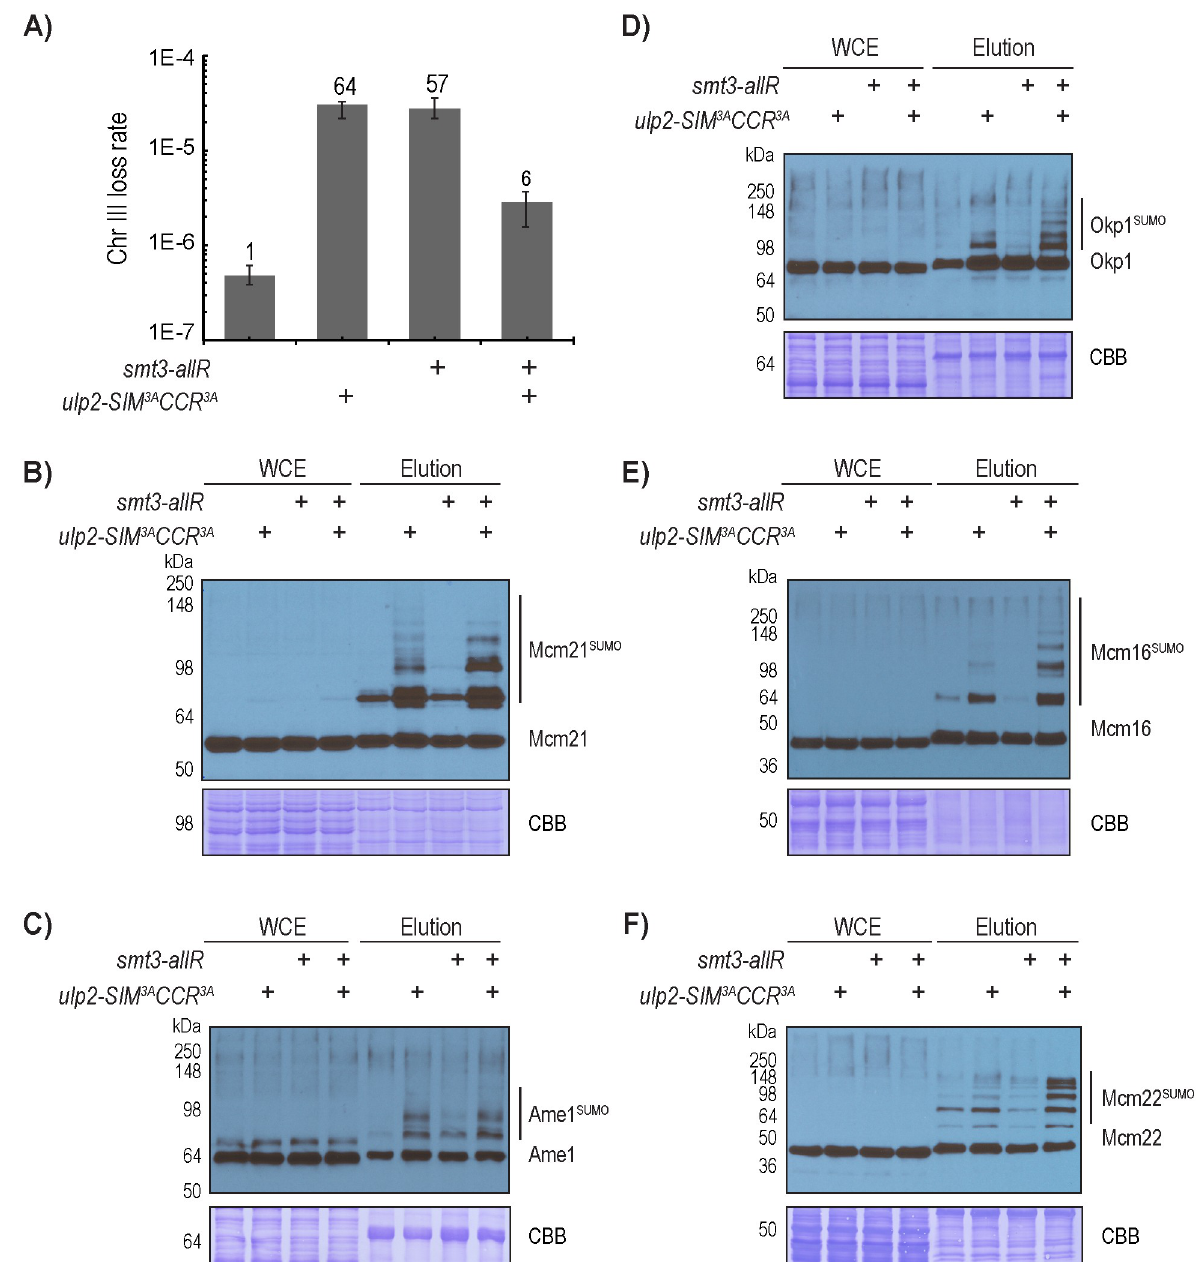
Fig 6. CCAN sumoylation and chromosome segregation are affected by changes in poly-sumoylation. A) Chromosome loss rates, measured by quantitative mating, of WT, smt3-allR , ulp2-SIM 3A CCR 3A , and smt3-allR ulp2-SIM 3A CCR 3A triple mutants (also see S8 Table). B-F) The effects of smt3-allR on the sumoylation patterns of CCAN subunits in wild-type ULP2 and the ulp2-SIM 3A CCR 3A mutant backgrounds.